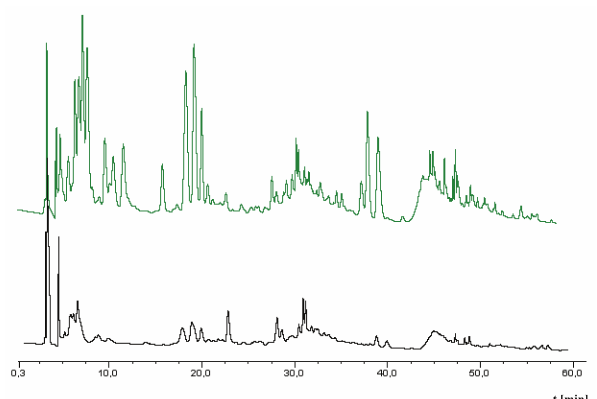
Figure 4: HPLC trace of E. brasiliensis extracts after acid hydrolysis (green line = Ebe; black line =